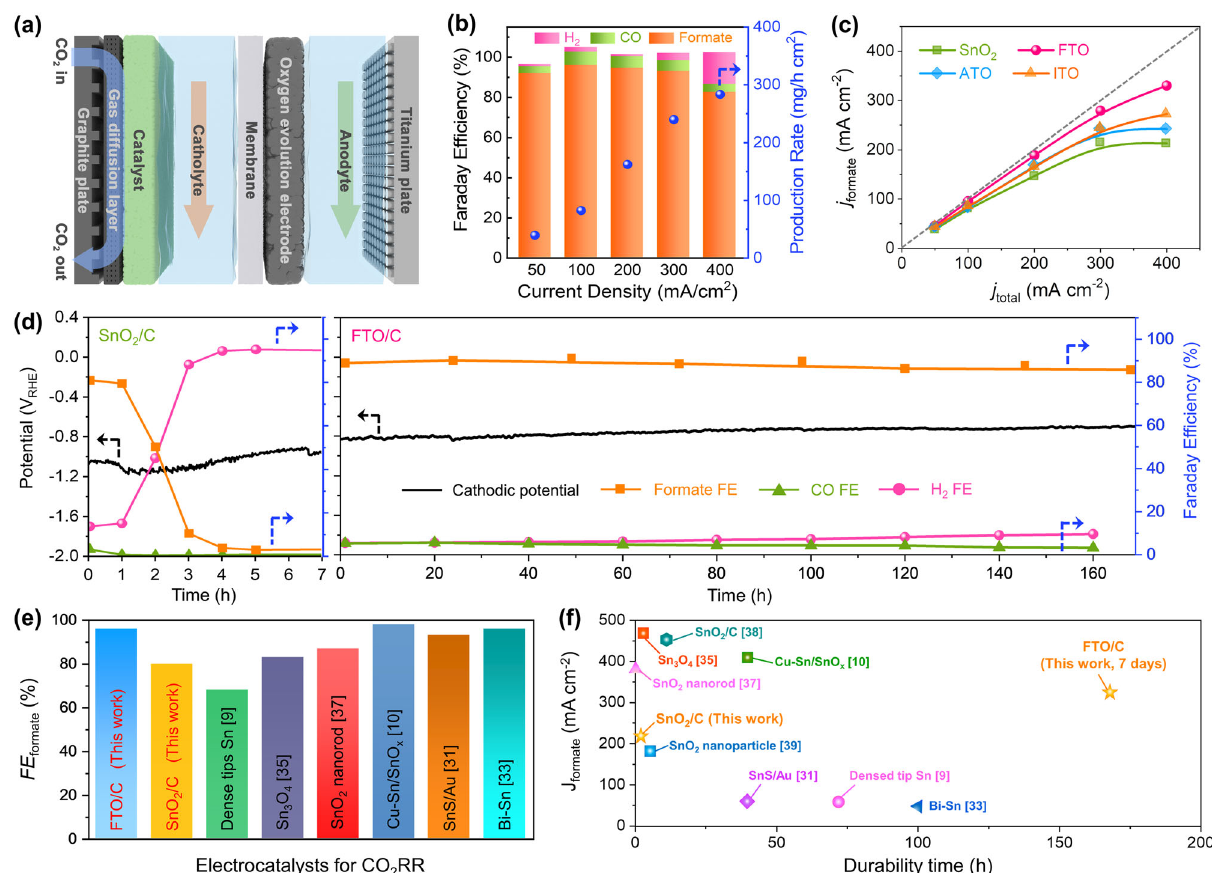
Fig. 2 Single-cell performances of Sn-based catalysts. a Schematic of the fl ow-type CO 2 electrolyzer using a gas-diffusion layer. b Faradaic ef fi ciencies of the products and production rates of formate for FTO/C catalyst at each given current density in 1 M KOH solution. c Partial current densities of formate for CO 2 RR in the current density range of 50 – 400 mA cm – 2 over those of the synthesized catalysts. The error bar was calculated from three independent tests. d Durability test of SnO 2 /C (left) and FTO/C (right) catalysts in the fl ow-type CO 2 electrolyzer in 1 M KHCO 3 solution. The faradaic ef fi ciencies of CO, H 2 and formate reported were observed during the durability test. e FE formate of advanced Sn-based CO 2 RR catalysts. f Plot of the partial current density of formate (mA cm − 2 ) versus the durability for various Sn-based CO 2 RR